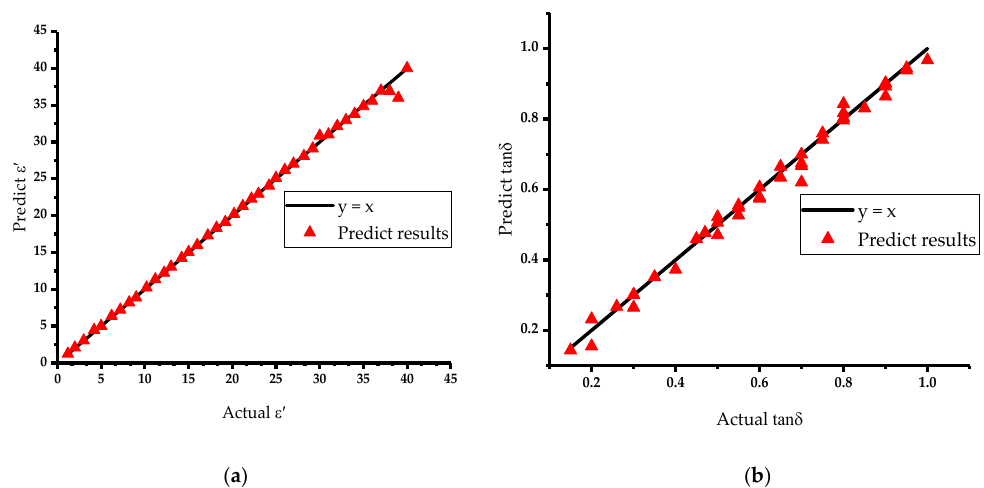
Figure 6. Permi tt ivity prediction results: ( a ) Prediction e ff ect of ε (cid:4593) ; ( b ) prediction e ff ect of tan δ . Figure 6. Permittivity prediction results: ( a ) Prediction effect of ε (cid:48) ; ( b ) prediction effect of tan δ .